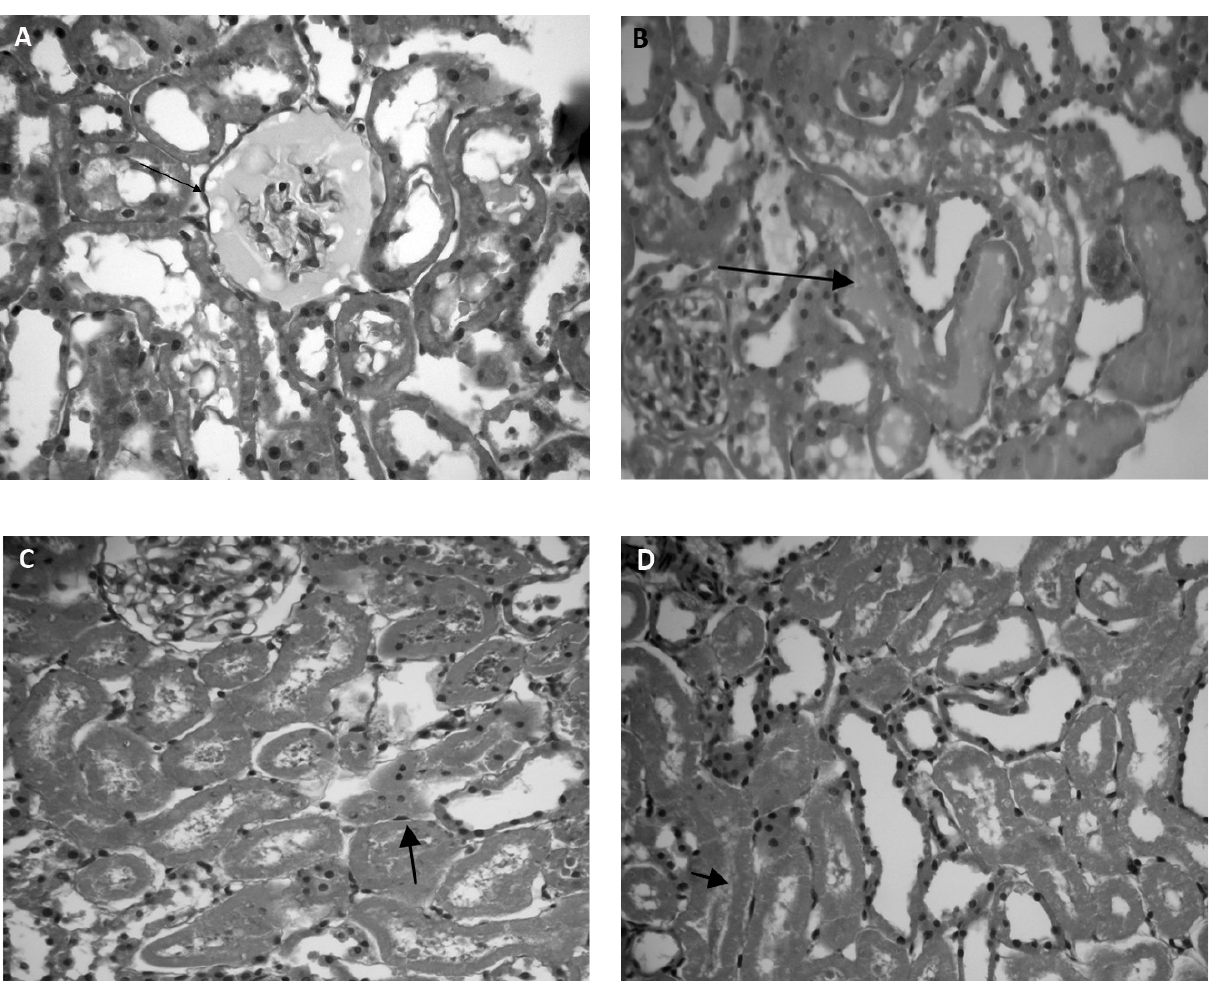
Figure 2. Photomicrograph of kidneys perfused with Polybia paulista venom (PPV) at a concentration of 3 μg/mL, which indicates ( A ) proteinaceous material in the urinary spaces and ( B ) tubules. Foci of necrosis, ( C ) nuclei and ( D ) cells without nuclei (hematoxylin-eosin,